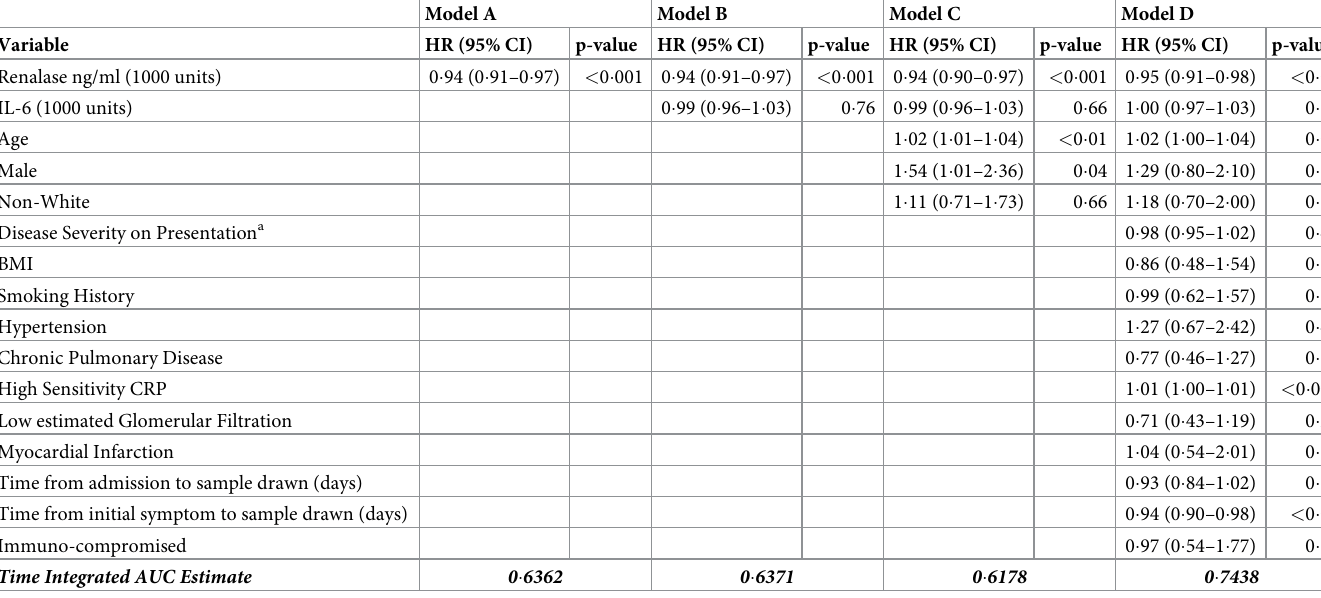
a Derived Severity Indicator = Yes if patient had any of severity variables on presentation (Tachypnea, Hypoxia, Initial Hypotension and Initial Respiratory